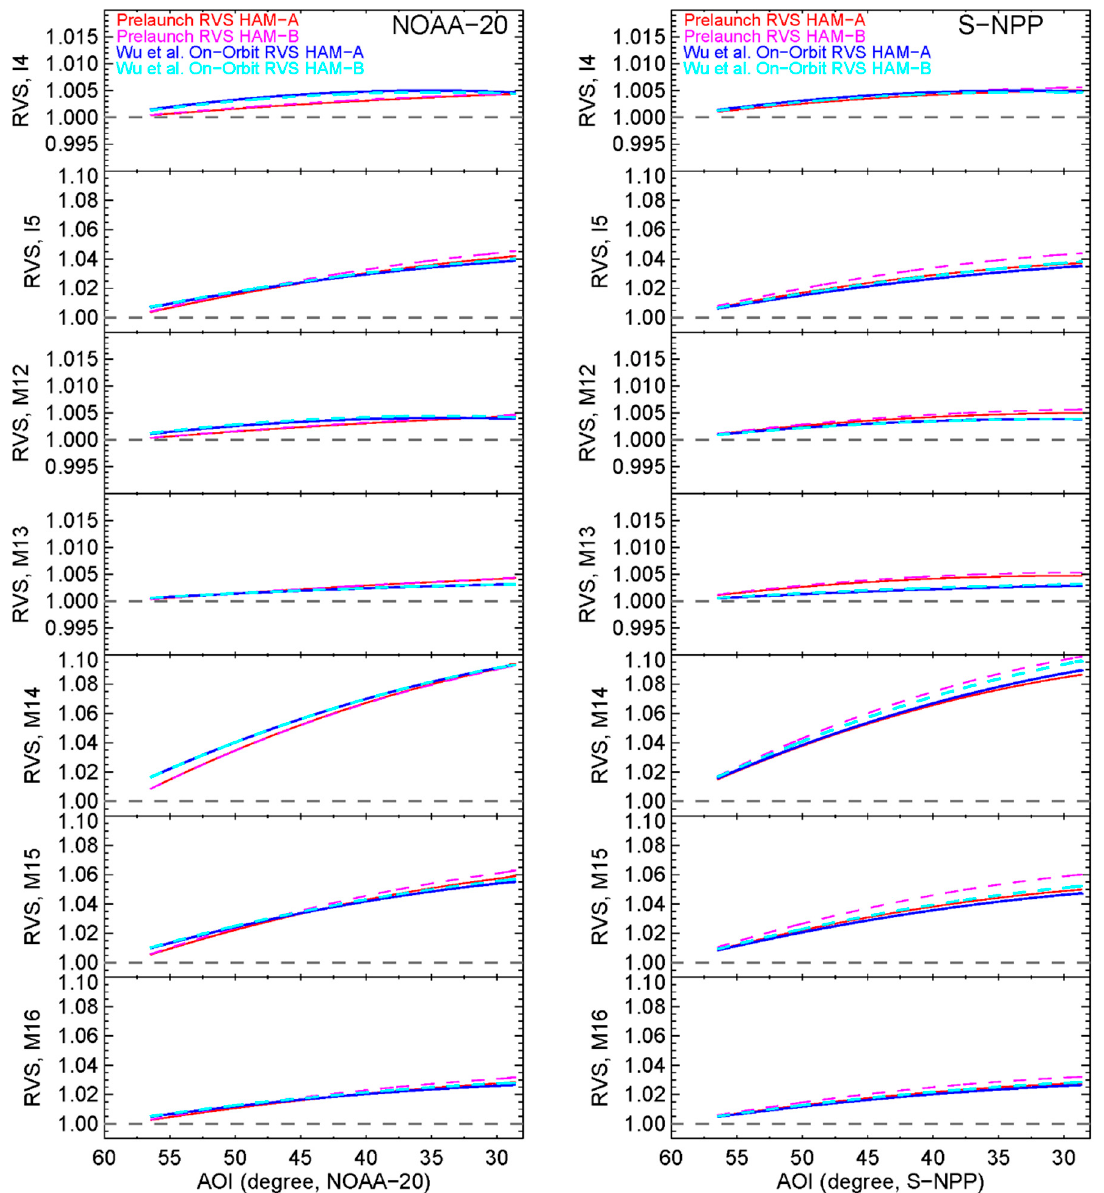
Figure 9. Comparison of band-averaged NOAA-20 (left panel) and S-NPP (right panel) prelaunch and